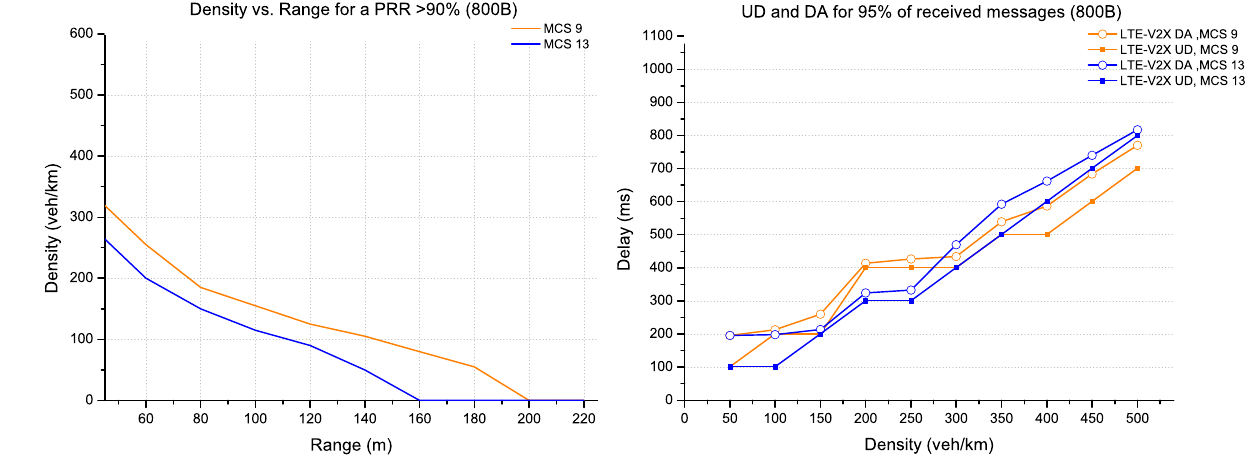
Figure 9. Evaluation for LTE-V2X technology (packet size 800 bytes). The CPM messages supporting large data (1200 bytes) are shown in Figure 10.